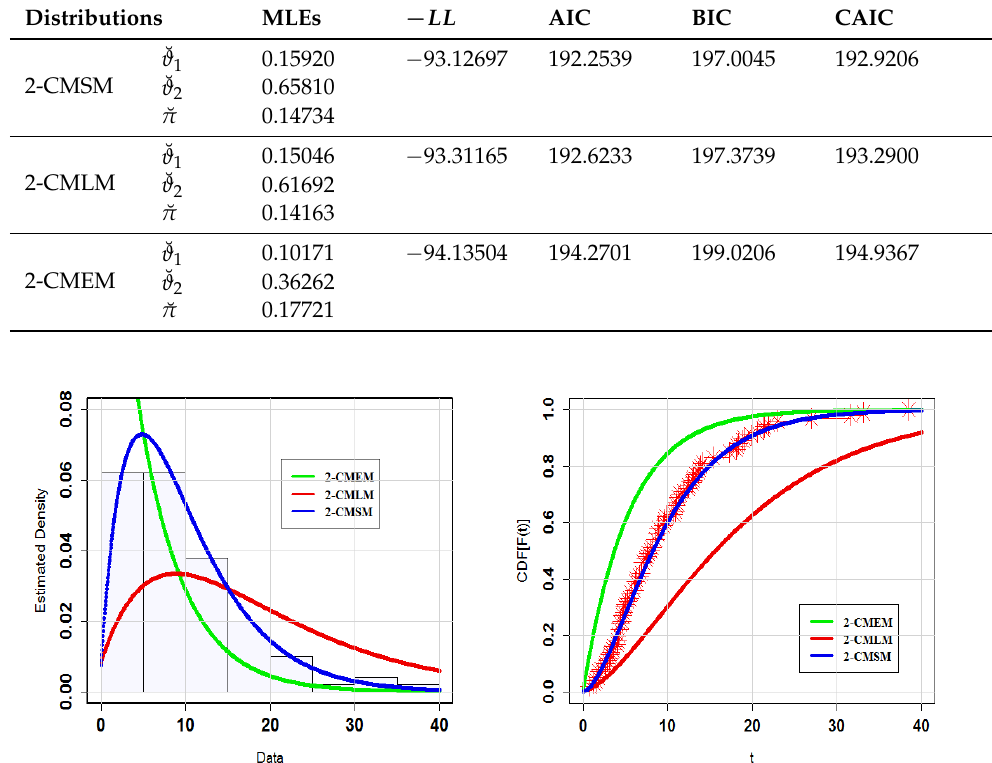
Table 2. MLEs, and GOF statistics for Dataset II.